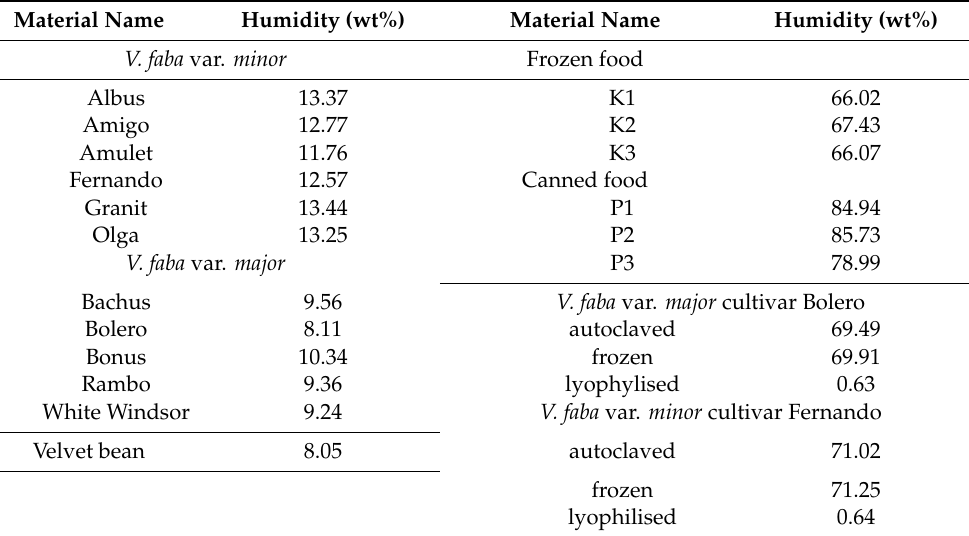
Table 6. Water content of materials examined in this